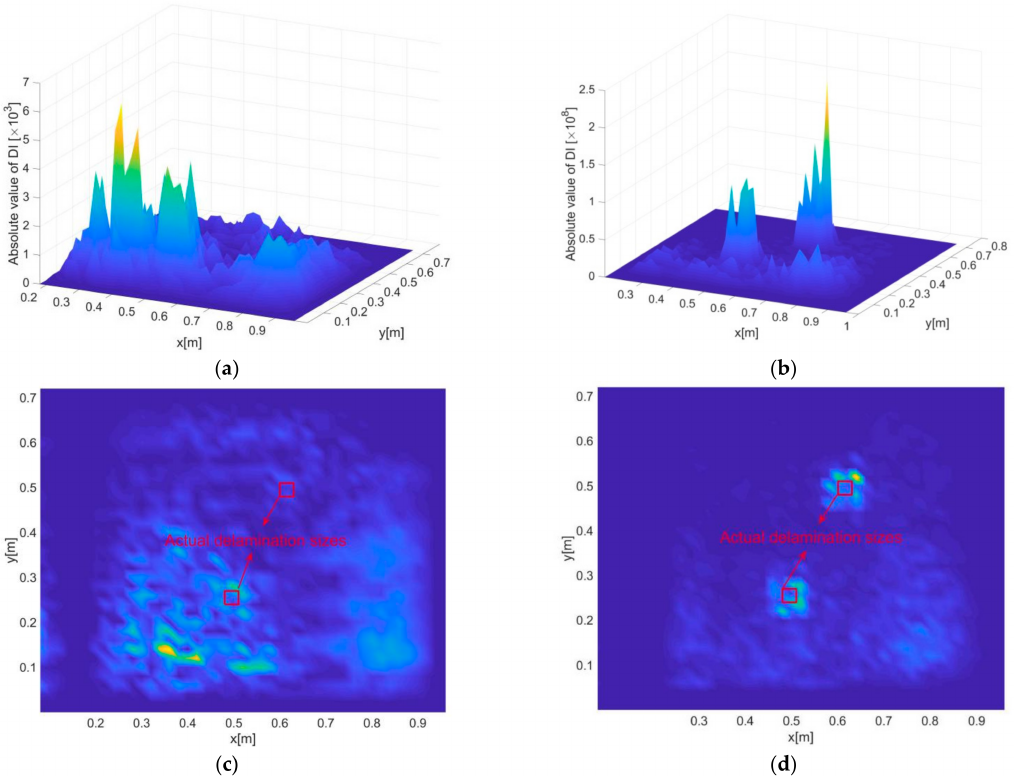
Figure 16. Delamination detection results for scenario C, where ( a ) and ( c ) present the three- and two-dimensional views of the results under excitation frequency of 100 Hz, and ( b ) and ( d ) present the three- and two-dimensional views of the results subject to hybrid data